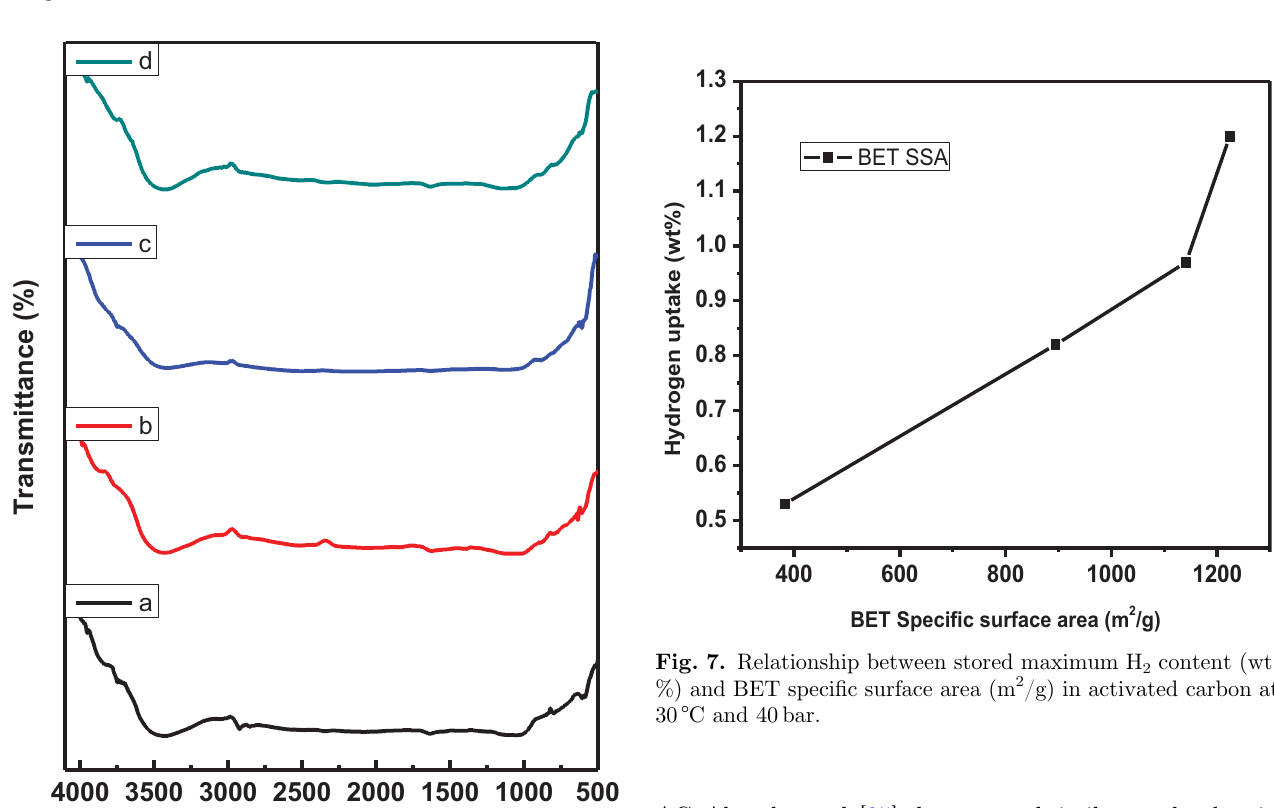
Fig. 4. Pore size distribution of activated carbon calculated using DFT method.